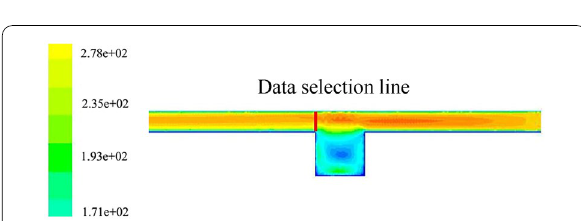
Figure 6 Schematic diagram of the location of the data selection line